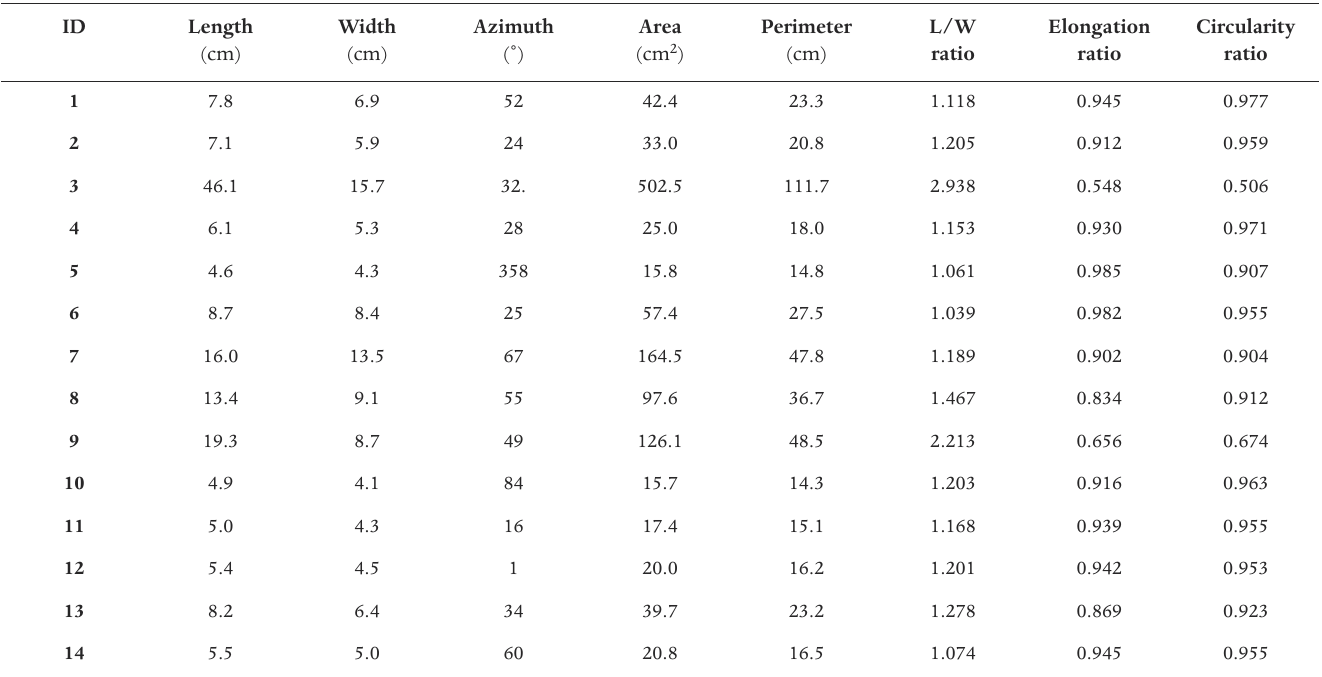
Table 2. Dimension and morphometric parameters of the craters (Figure 4, orange) derived from the DEM analysis. Azimuth, semi-major axis of